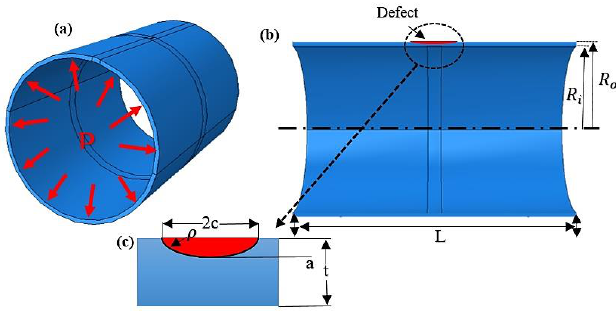
Figure 3. Schematic of dimension model: ( a ) Pipe 3D model, ( b ) dimensions of geometry model with defect, ( c ) characteristics of defect.